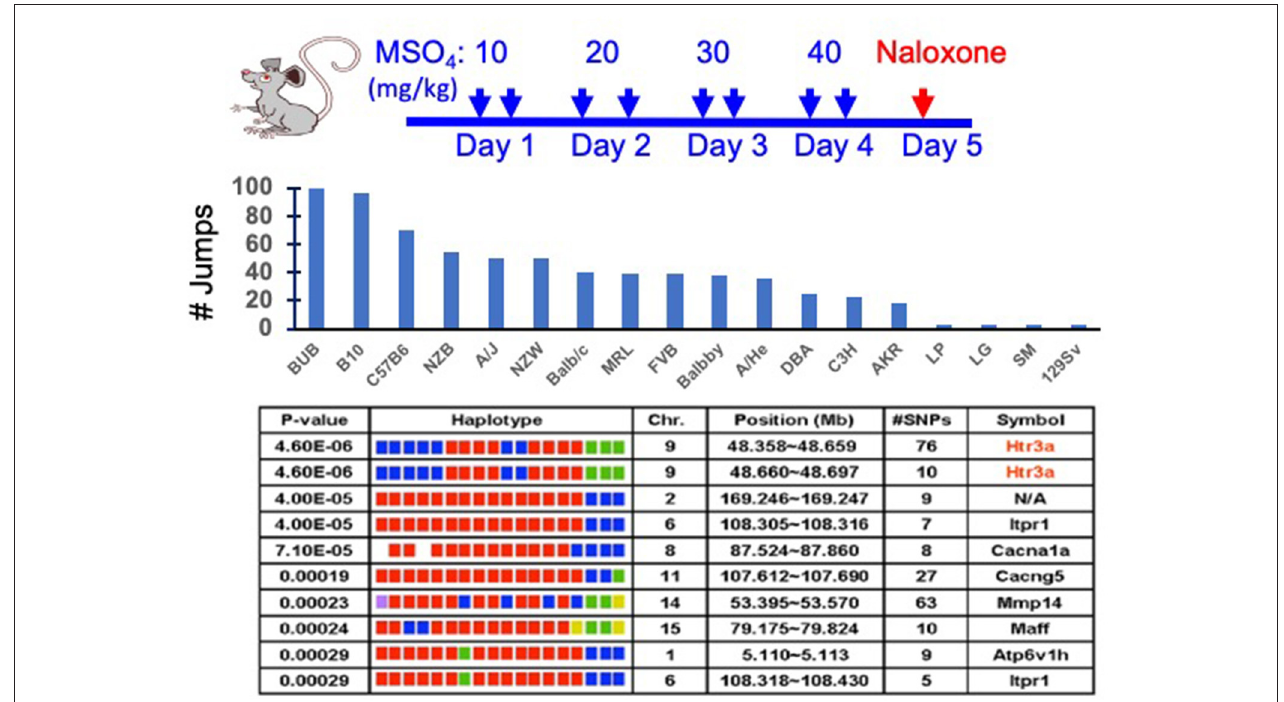
FIGURE 1 | Analysis of a murine genetic model of naloxone precipitated opiate withdrawal (NPOW). (Top) Eighteen strains (eight mice per strain) were treated for four days with morphine to establish physical dependence. On the 5th day, the number of jumps made during the 15-min period after naloxone injection was measured to indicate the degree of opioid dependence. (Middle) The data represent the mean number of jumps for each indicated strain. (Bottom) The NPOW data (mean number of jumps for each strain) was analyzed by haplotype based computational genetic mapping. The 10 most strongly correlated haplotype blocks are shown. For each block, the chromosomal location, number of SNPs within a block and its gene symbol are listed. For each gene, the haplotypes are represented by a colored block, and the blocks are presented in the same rank order as the phenotypic data. Strains sharing the same haplotype have the same-colored block. The calculated p -value measures the probability that the strain groupings within a block would have the same degree of association with the phenotypic data by random chance. The genetic effect indicates the fraction of the inter-strain variance that is potentially attributable to the